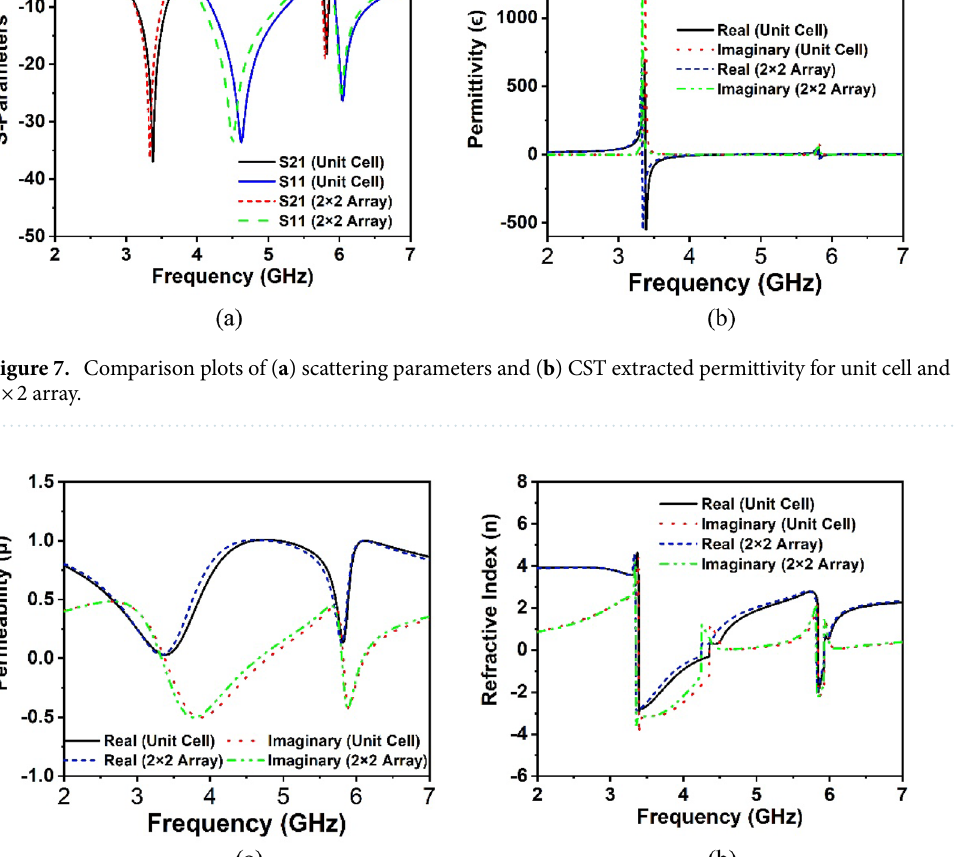
Figure 8. Comparison plots of CST extracted ( a ) permeability and ( b ) refractive index for unit cell and 2 × 2